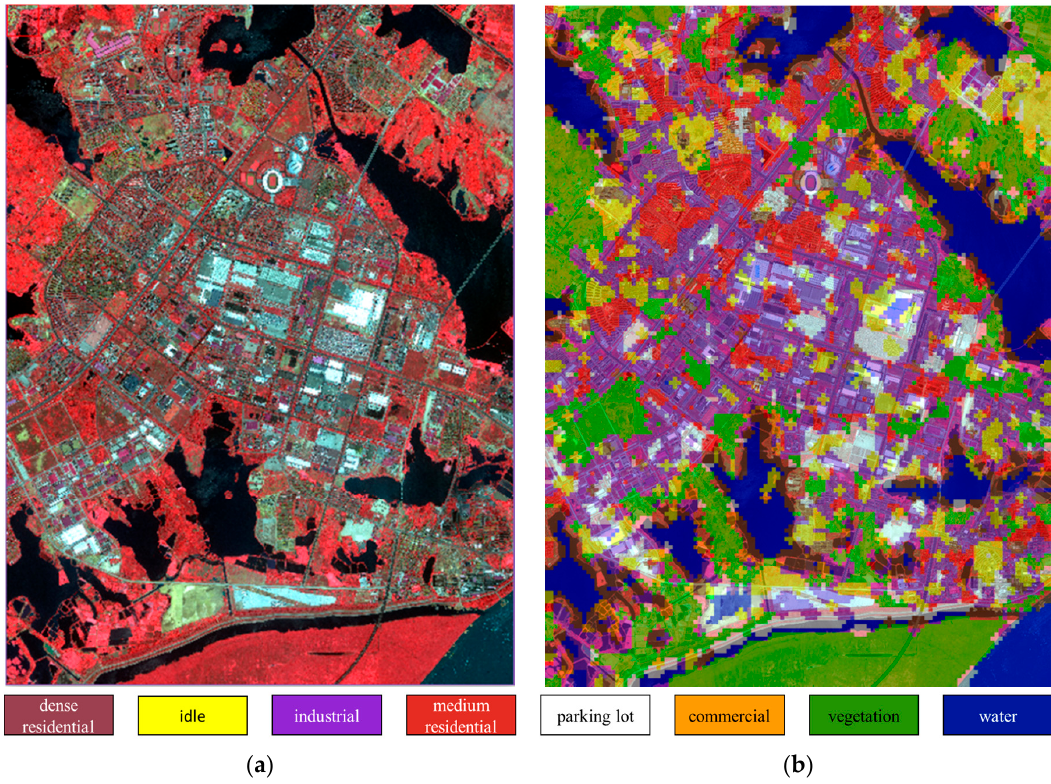
Figure 12. Wuhan IKONOS large image and its scene understanding result: ( a ) the original image; and ( b ) the scene understanding result.